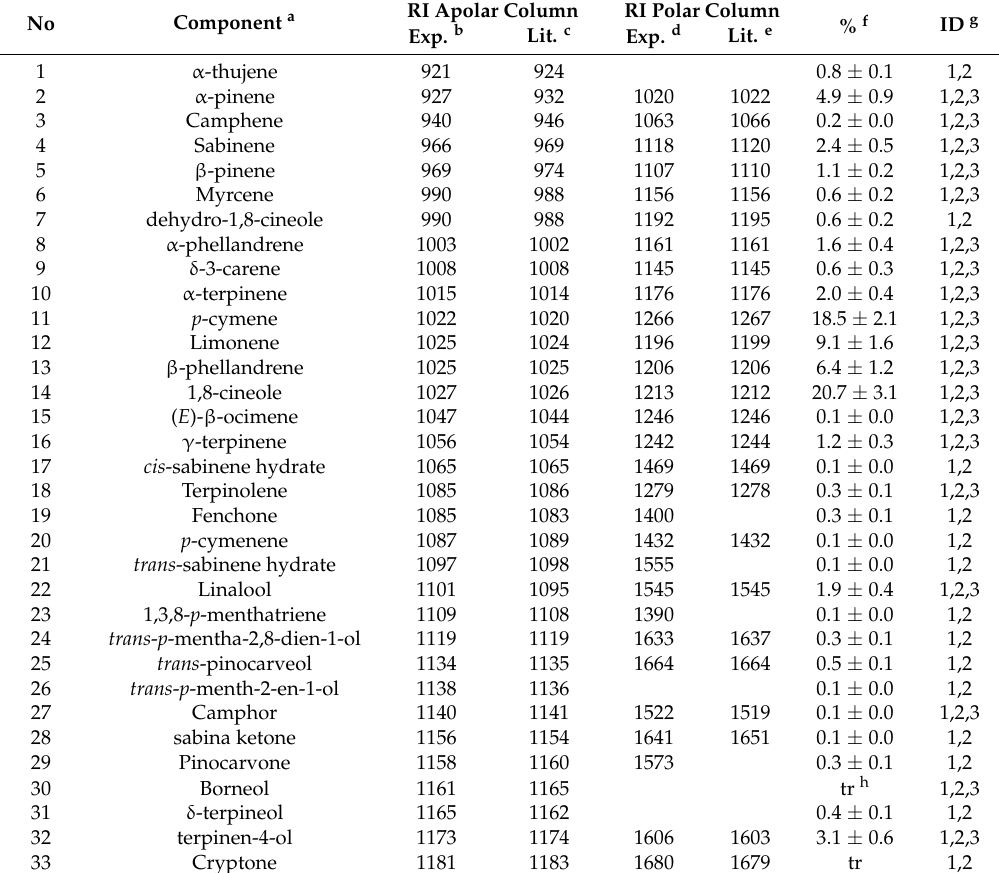
Table 1. Chemical composition of the essential oil obtained from the leaves of Peumus boldus